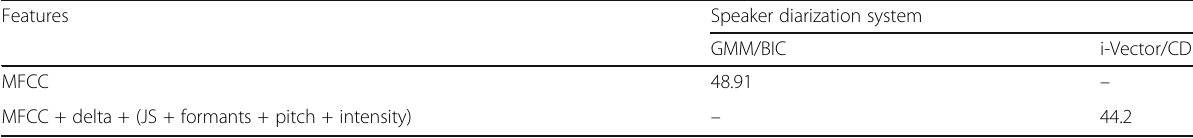
Table 2 Speech activity detector (SAD) experiments for the baseline and the best performing system